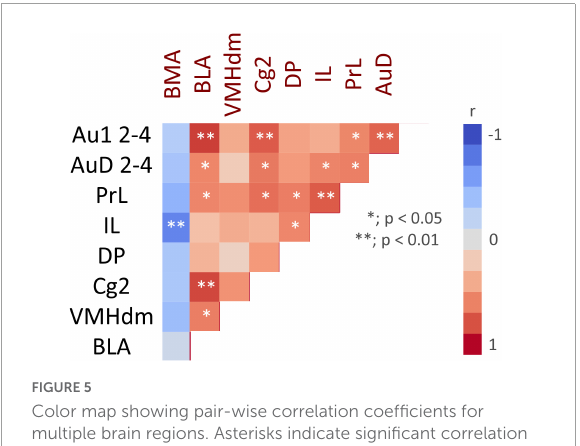
FIGURE5 Color map showing pair-wise correlation coefficients for multiple brain regions. Asterisks indicate significant correlation